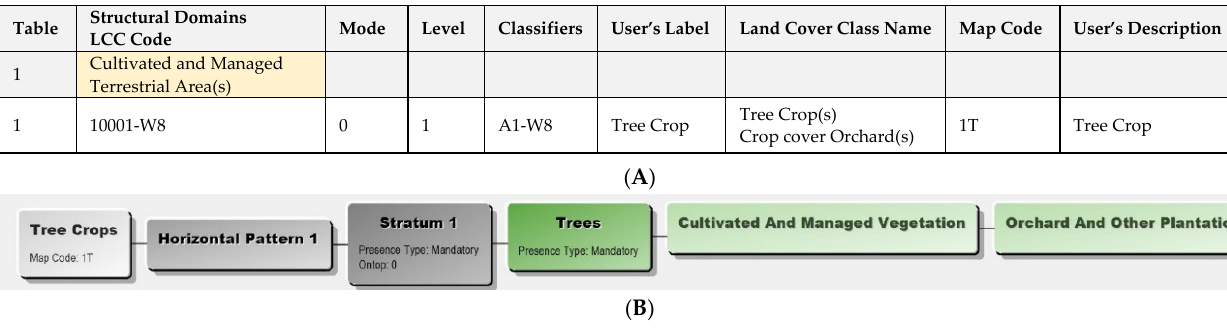
Figure 4. Himalaya land cover legend. ( A ) Land cover class ‘’tree crop” using LCCS2 and ( B ) land cover class ‘’tree crop” using LCCS3.